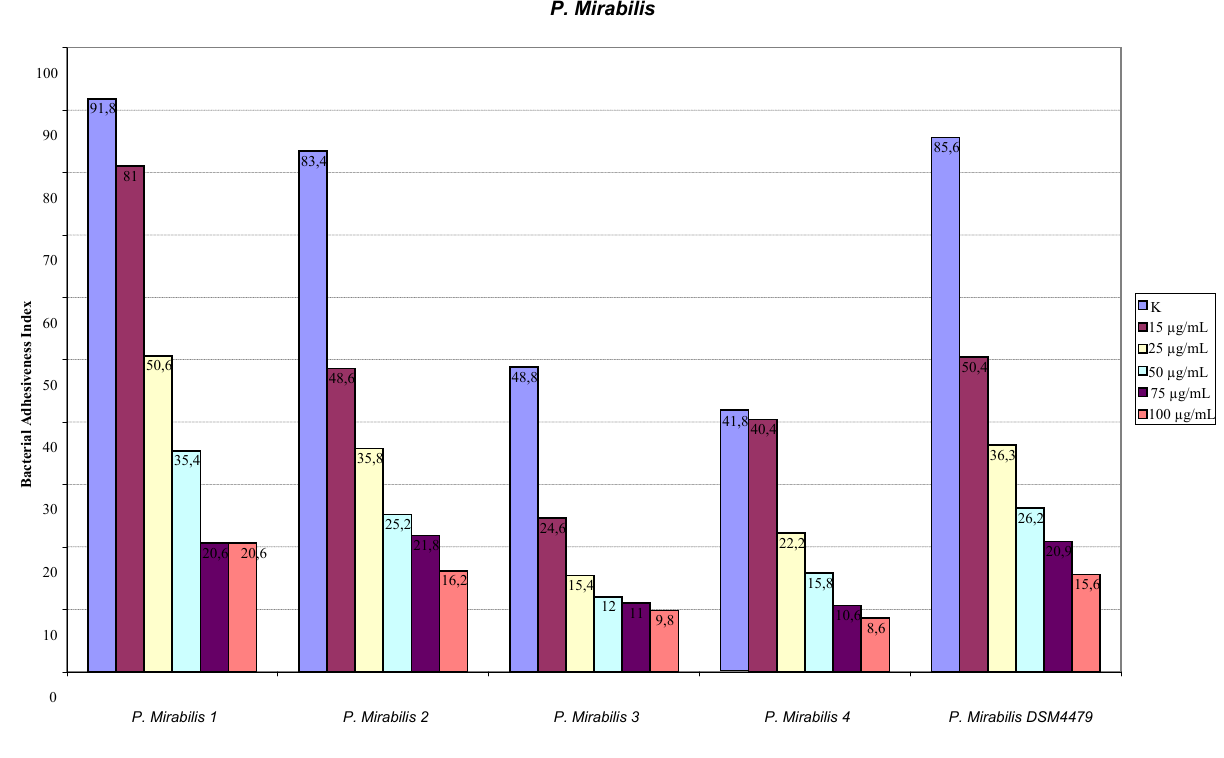
Figure 2. Adhesion indexes for the strains of P.mirabilis . In both figures the reduction of the adhesion indexes is clear.